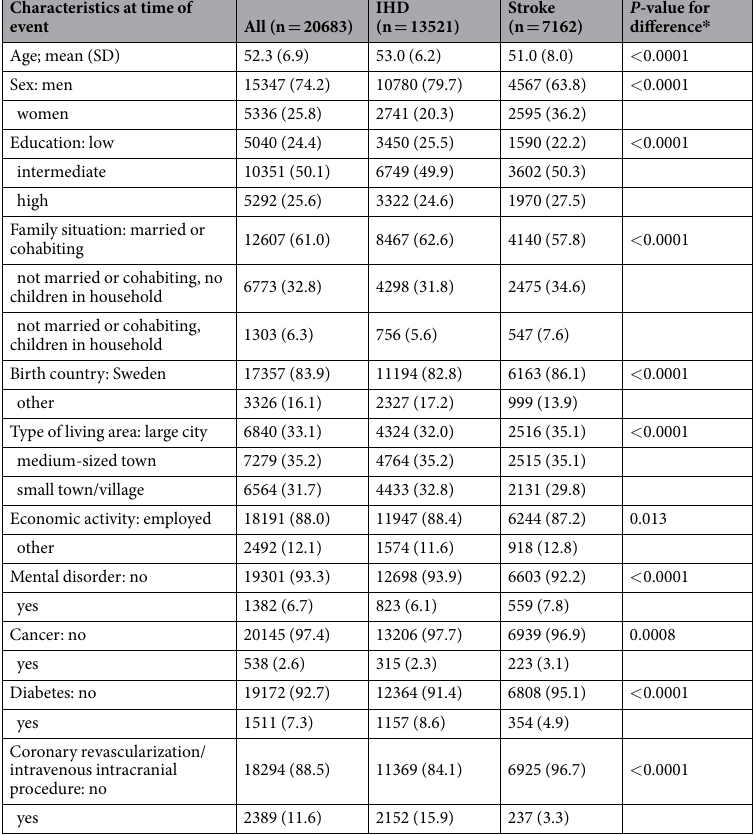
Table 1. Descriptive characteristics at time of event among a cohort with newly diagnosed ischemic heart disease (IHD) or stroke. Figures are number (%) unless otherwise stated. * P -value for difference between IHD and stroke